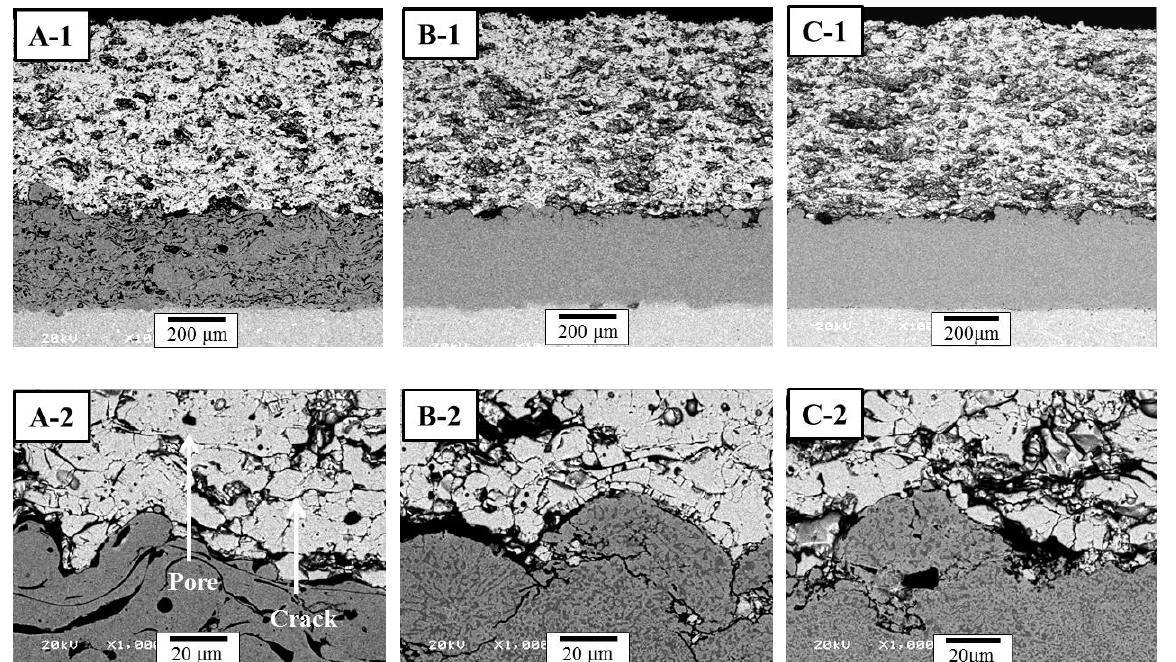
Figure 2. Cross-sectional microstructures of as-prepared thermal barrier coating (TBCs): ( A ) TBC with air-plasma spray (APS) bond coat; ( B ) Thermal barrier coating (TBC) with HVOF bond coat; and ( C ) TBC with low-pressure plasma spray (LPPS) bond coat. Each number indicates the overall and interface microstructures,